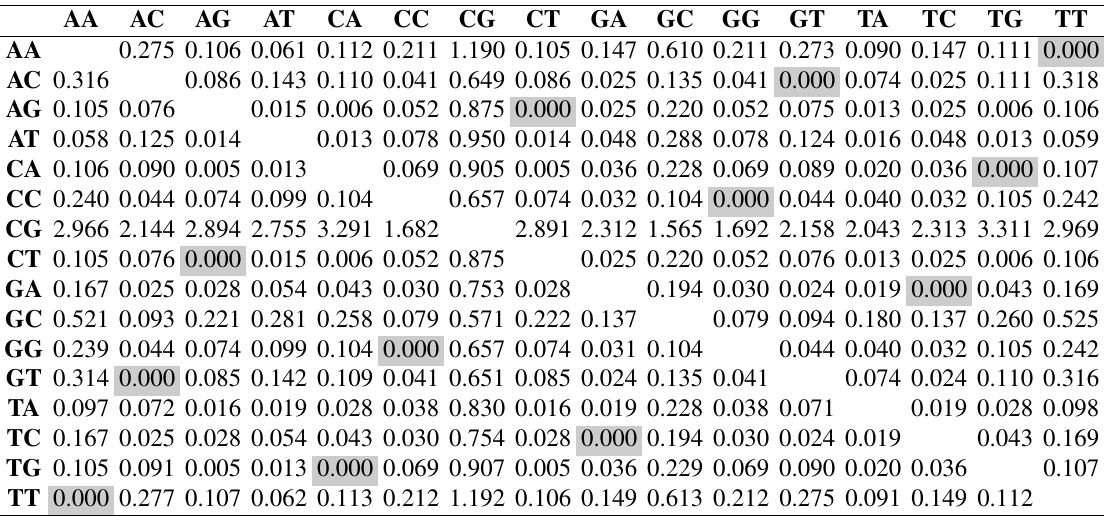
Table 1: Kullbak-Leibler divergence between the 16 dinucleotides in the whole-genome distance distribution. The highlighted values (in grey) correspond to reversed complement dinucleotide pairs.